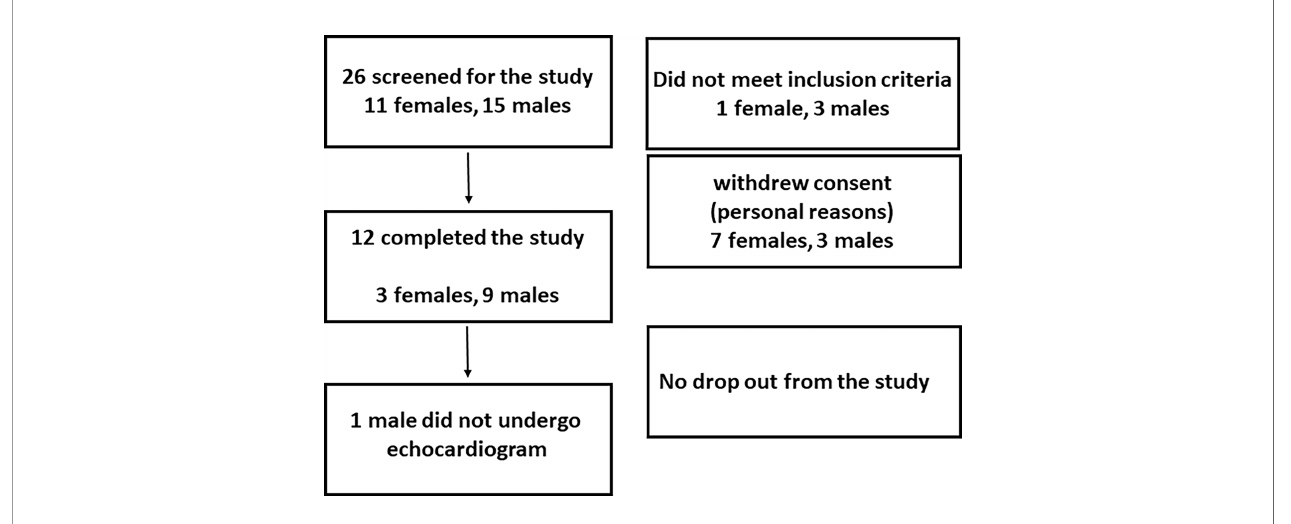
FIGURE 3 | CONSORT chart.